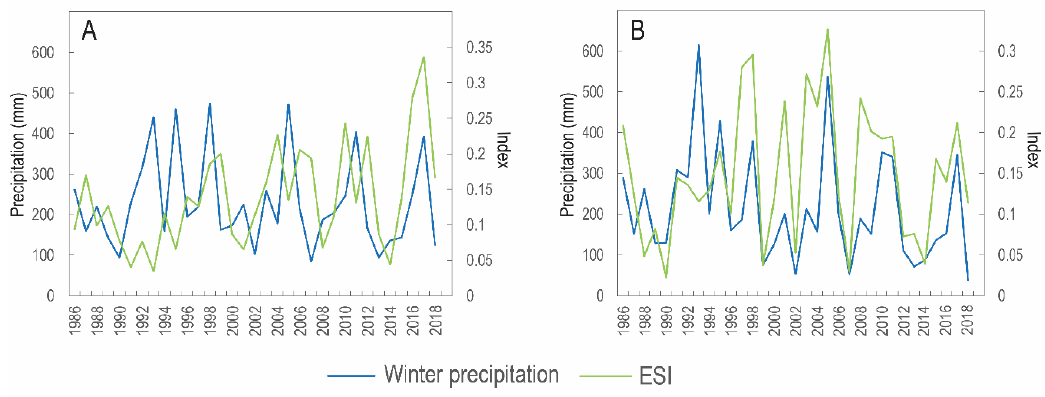
Figure 9. Yearly winter precipitation (Oct – April) and ESI index values averaged for turbines in the Tehachapi ( A ) and those in Desert Hot Springs ( B ) study sites.